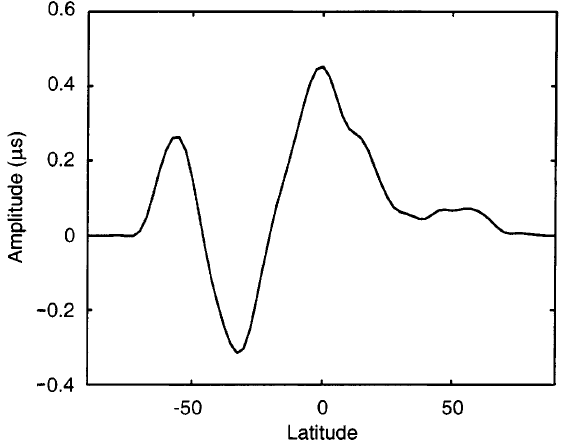
Fig. 3. Distribution of contributions over rings of 2.5 (cid:176) latitude width to the global AAM trend. The ordinate is height in kilometers (km). Values are given in units of 10 ) 6